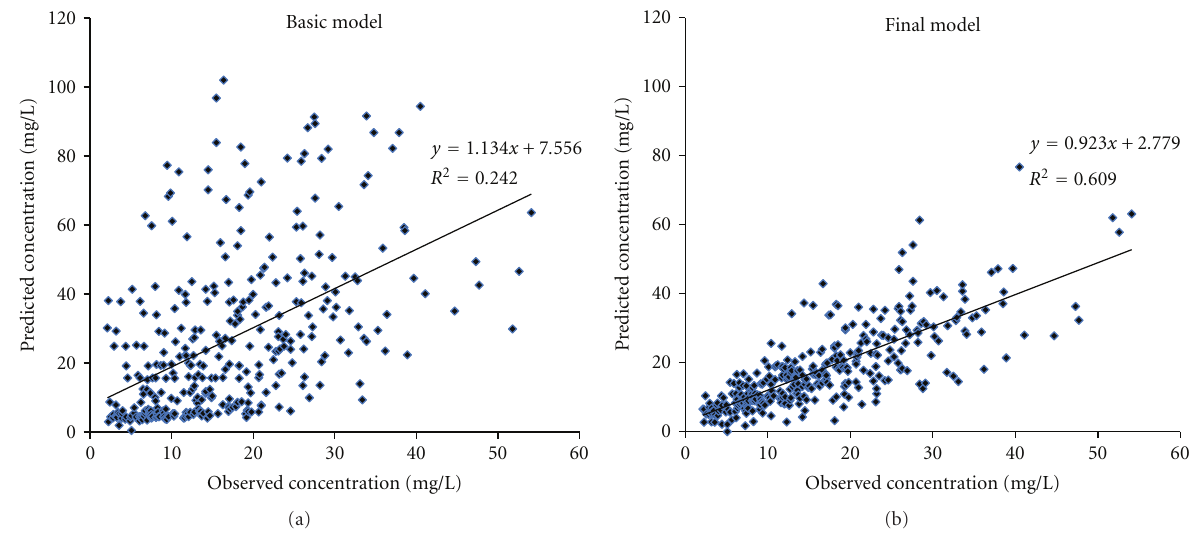
Figure 2: Scatter plot of observed against predicted concentrations in modeling group obtained from basic model (two-compartment model, without covariate) and final model (two-compartment model, with